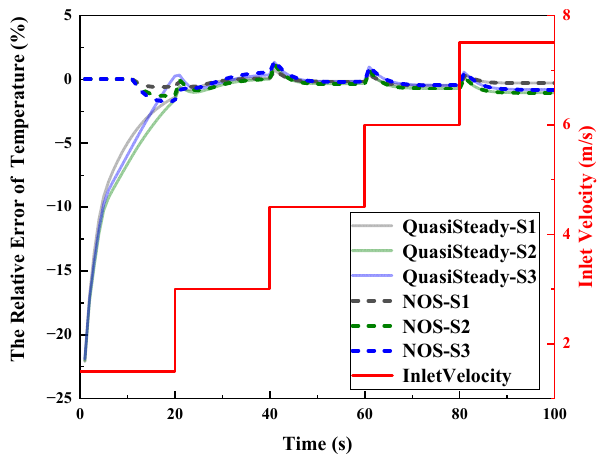
Figure 11. The relative errors of the average temperature of the three rectangular block surfaces obtained using the quasi-steady algorithm and the novel optimization strategy after adding velocity perturbations at different time periods relative to the results of the traditional coupling algorithm.